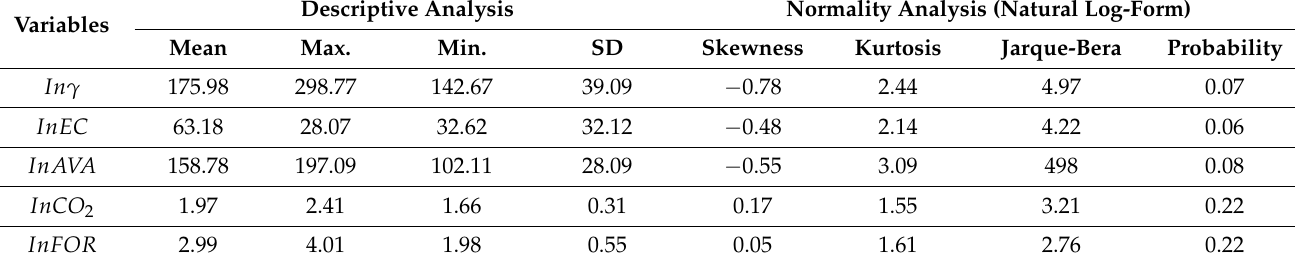
Table 2. Descriptive statistics of the variables.